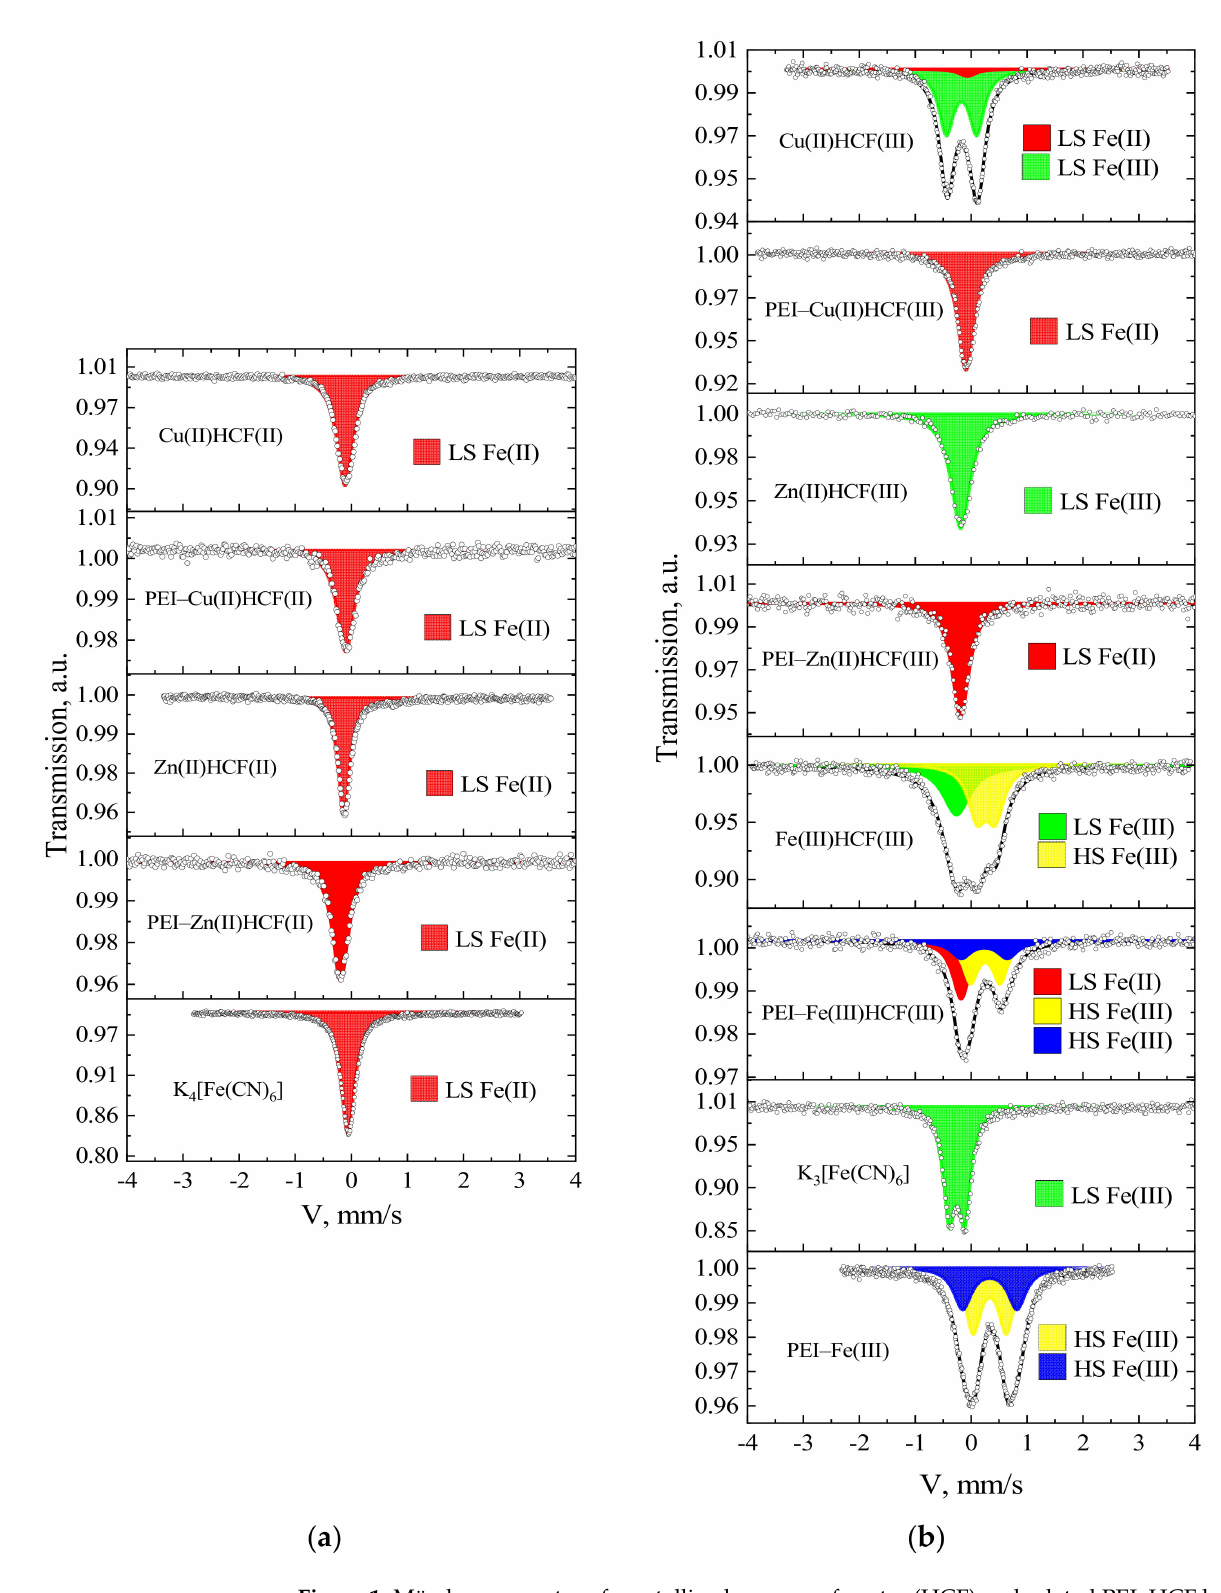
Figure 1. Mössbauer spectra of crystalline hexacyanoferrates (HCF) and related PEI–HCF hybrids obtained using K 4 [Fe II (CN) 6 ] ( a ) and K 3 [Fe III (CN) 6 ] ( b ) as precursors: dots are experimental data; lines are spectra fits obtained with the WinNormos